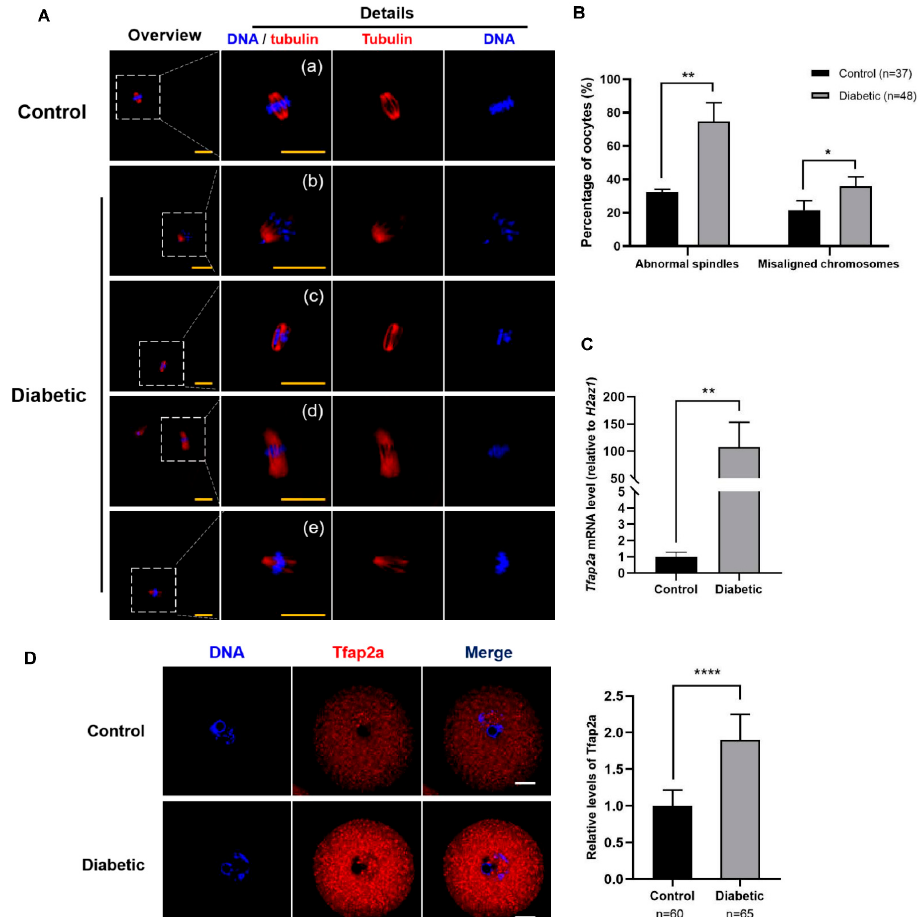
Figure 1. Maternal diabetes-induced spindle defects and chromosome misalignment in MII oocytes and a high level of Tfap2a in GV oocytes. ( A ) Spindle and chromosome morphologies in MII oocytes after in vitro maturation for 14 h in the control and diabetic mice. Most oocytes in the control group showed normal spindle and chromosome alignment (a), whereas in the diabetes group, oocytes re- vealed asymmetrical (b), elongated (d), and multipolar (c and e) spindles, and some chromosomes moved to the poles of the spindle (b) or clustered on the metaphase plate (c). Magnifications of the boxed regions are shown on the right side of each main panel. Tubulin is shown in red, and DNA is indicated in blue. Scale bar = 20 µm. ( B ) Quantification analysis of MII oocytes with spindle defects and chromosome misalignment from control or diabetic mice. The data are expressed as the mean ± SEM of at least three independent experiments. * p < 0.05, ** p < 0.01. ( C ) Relative mRNA expression of Tfap2a in GV oocytes from the control and diabetic mice. Levels of expression were normalized to levels of H2az1 , and each bar represents the mean ± SEM ( n = 4). ** p < 0.01. ( D ) Images of the